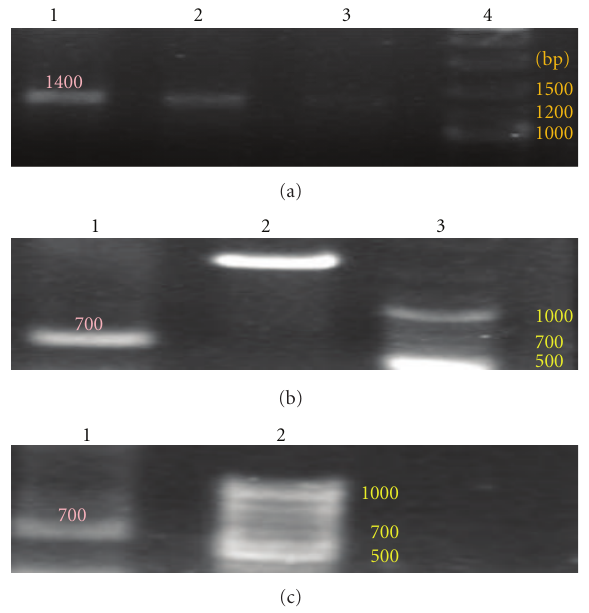
Figure 2: (a) FVII-PCR product, Lanes (1, 2, 3), 100 bp DNA ladder (4) (b) Restriction analysis of PCR product . Lane 1: digestion with HphI that revealed a 700bp fragment, Lane 2: PCR product without enzyme e ff ect. (c) Lane 1: 700-bp PCR product obtained by heminested